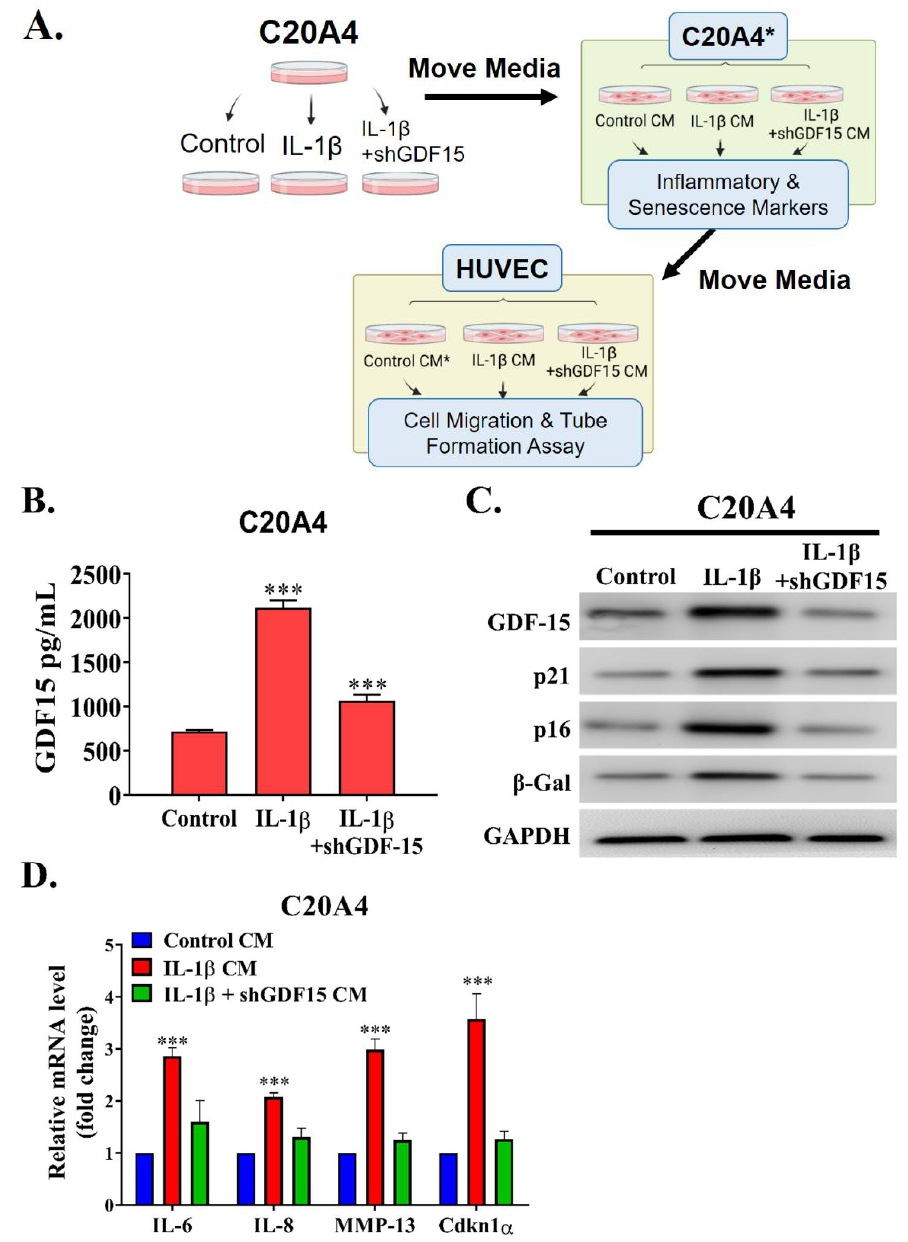
Figure 3. GDF15 affects chondrocytes in an autocrine/paracrine manner. ( A ) Schematic of the establishment of the GDF15 paracrine/autocrine circuit experimental model. ( B ) ELISA analysis of the GDF15 level in the medium of IL-1 β -stimulated C20A4 cells transfected with shGDF15 (GDF15-loss group) compared with shScramble (Inflammation group). ( C ) Western blot analysis of C20A4 cells incubated in the conditioned medium of the inflammation group and GDF15-loss group. ( D ) qRT-PCR analysis of the SASP-associated markers IL-6, IL-8, MMP-13, and Cdkn1 α mRNA expression levels in C20A4 cells incubated in the conditioned media of the inflammation and GDF15-loss groups. *** p < 0.001.